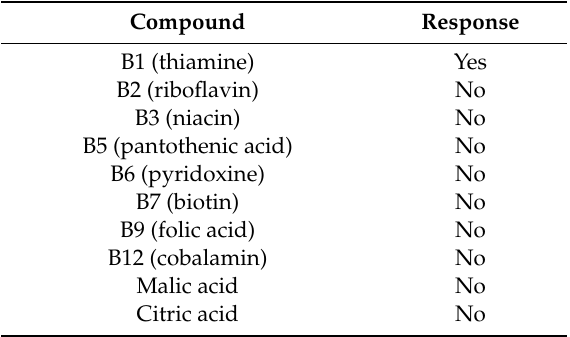
Table 3. Selection of water-soluble vitamins and additives present in food supplements, which were examined as potential interferences.